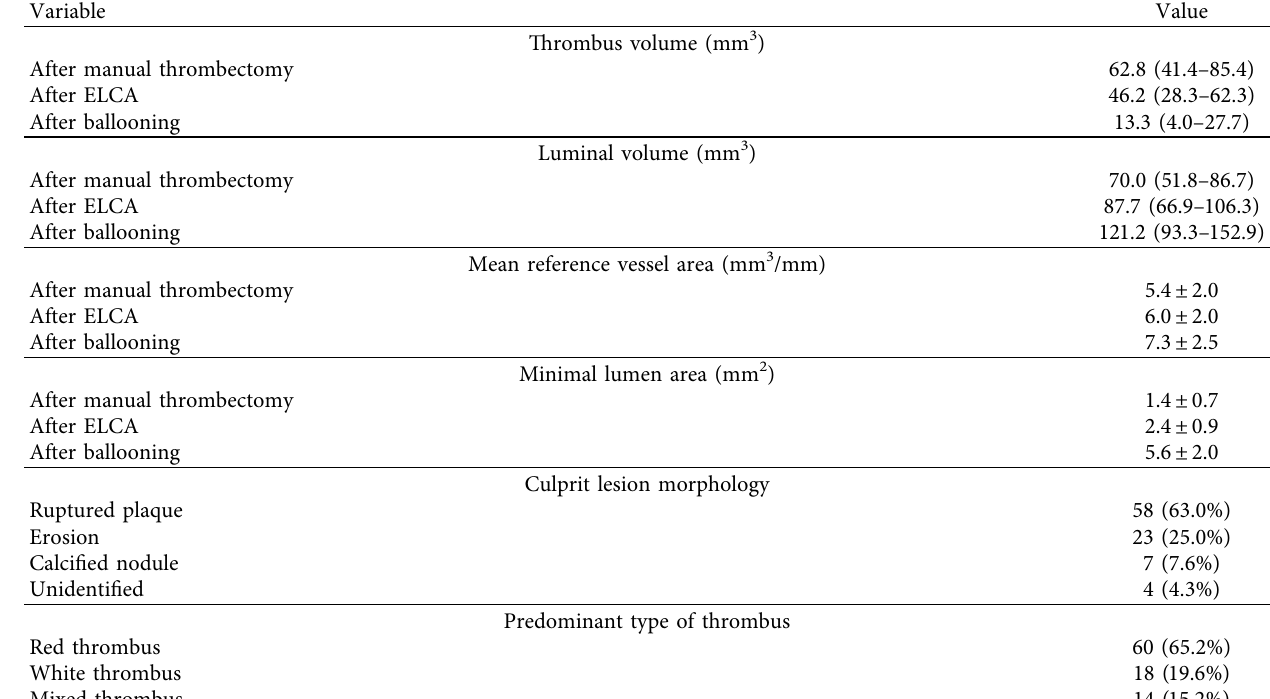
Table 3: Results of optical coherence tomography results.